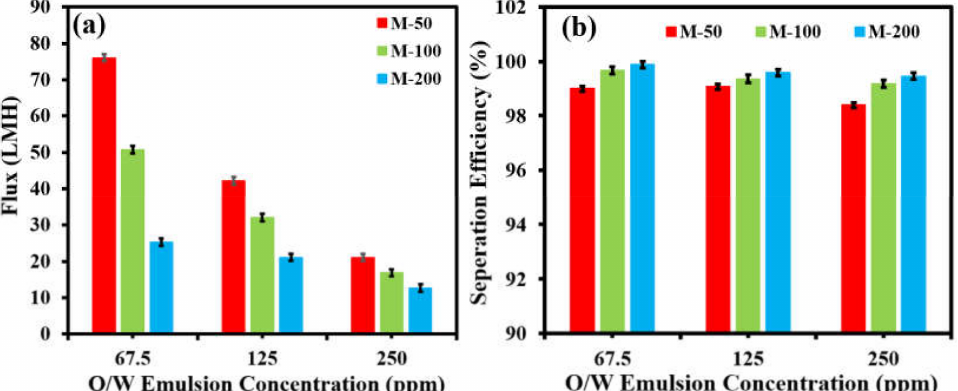
Figure 9. Effect of oil concentration on ( a ) permeate flux and ( b ) separation efficiency of all membranes at 1